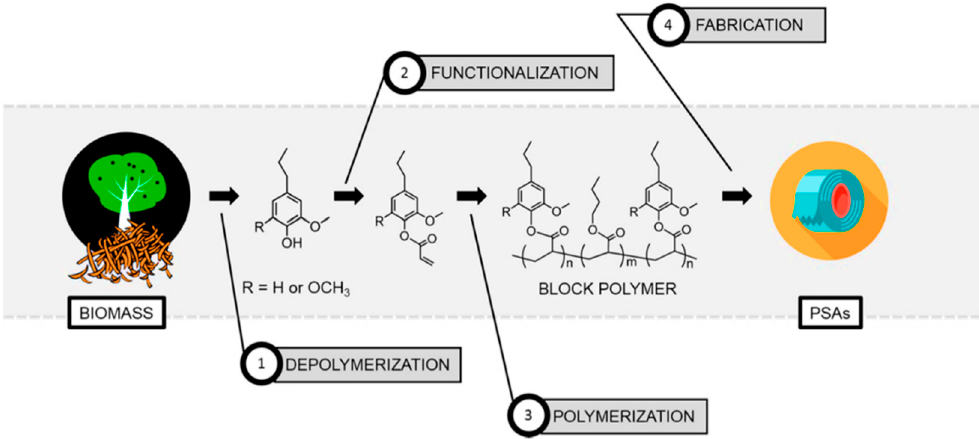
Figure 11. Material development from raw biomass to pressure-sensitive adhesives. Reproduced with permission